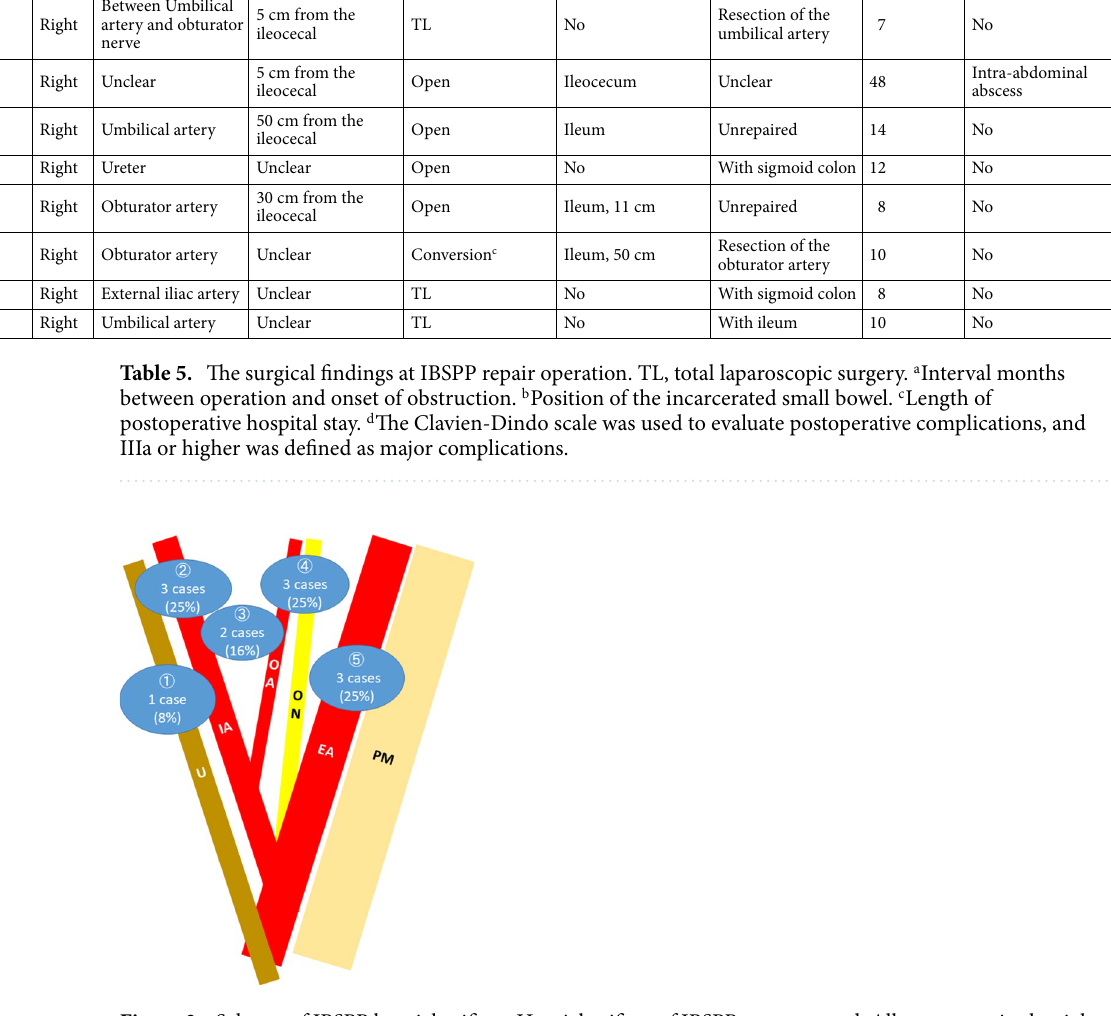
Figure 3. Schema of IBSPP hernial orifices. Hernial orifices of IBSPP are presented. All cases were in the right lymph node dissection space. In one case, the detailed onset site was unclear. PM, Psoas muscle; EA, External iliac artery; IA, Internal iliac artery; OA, Obturator artery; ON, Obturator nerve; U, Ureter. (1) Caused by the right ureter. (2) Caused by the right Internal iliac artery. (3) Caused by the right triangle space of the internal iliac artery and obturator artery. (4) Caused by the right obturator artery. (5) Caused by the right external iliac artery. This figure was drawn by corresponding author using Microsoft PowerPoint 2013 (https ://www.micro soft.com/ja-jp/micro soft-365/previ ous-versi ons/micro soft-power point